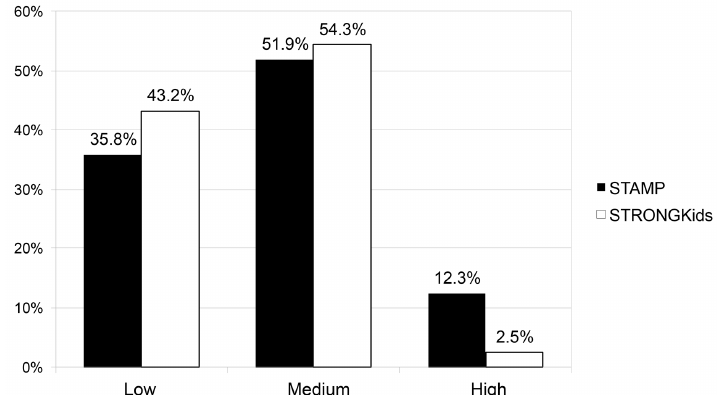
Figure 1. Comparison of the distribution of nutritional risk according to the scale used. STAMP: Screening Tool for the Assessment of Malnutrition in Paediatrics; STRONGkids: Screening Tool for Risk On Nutritional status and Growth.